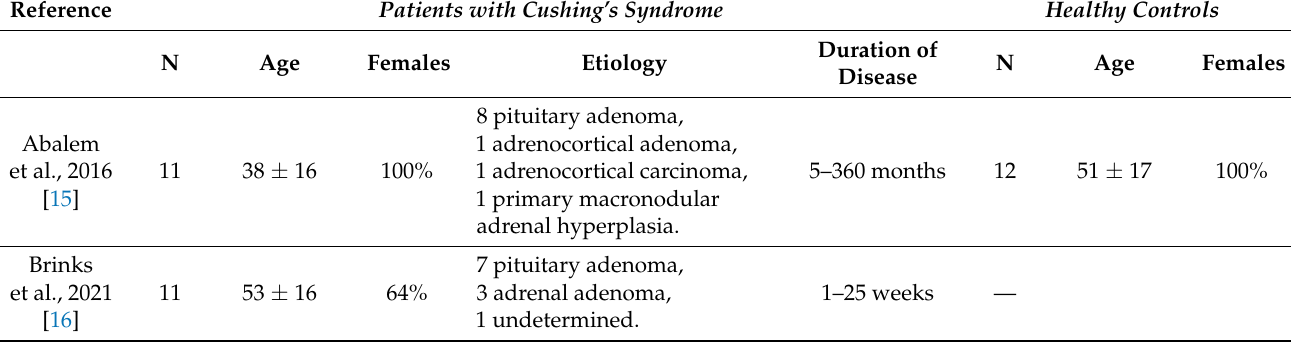
Table 3. Participant